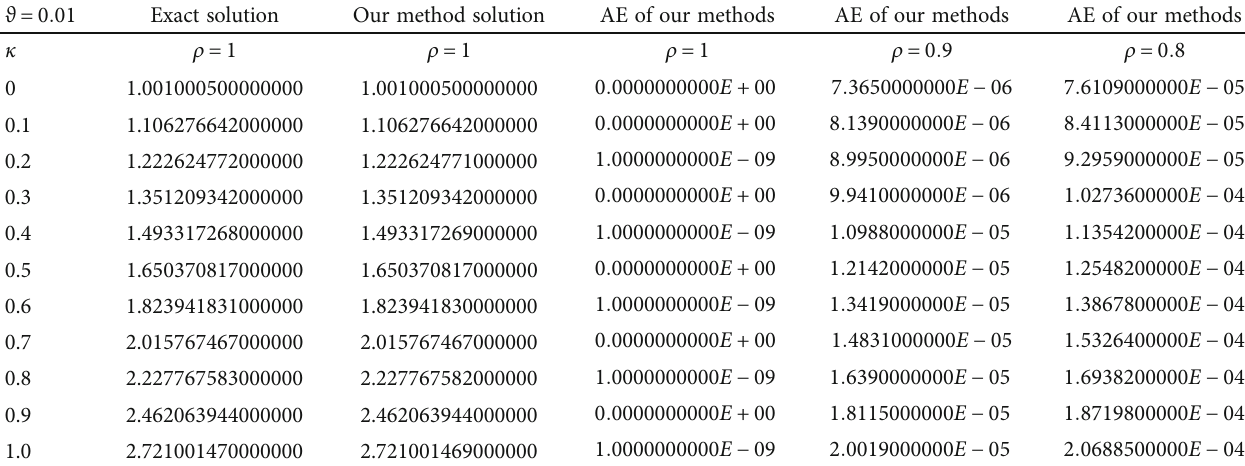
Table 1: Comparison of the exact and suggested method solution with the aid of absolute errors for problem